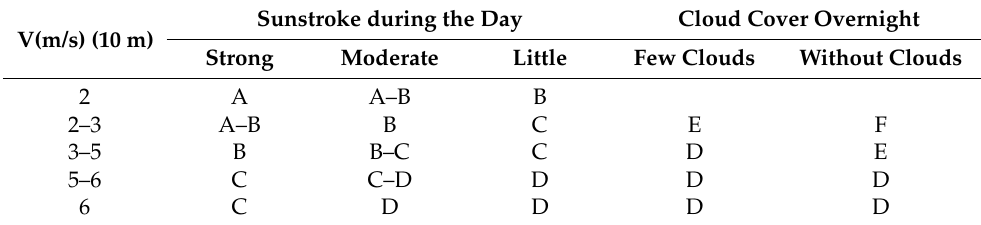
Figure 7. Modeling sceneries. Table 6. Pasquill–Gifford–Turner dispersion